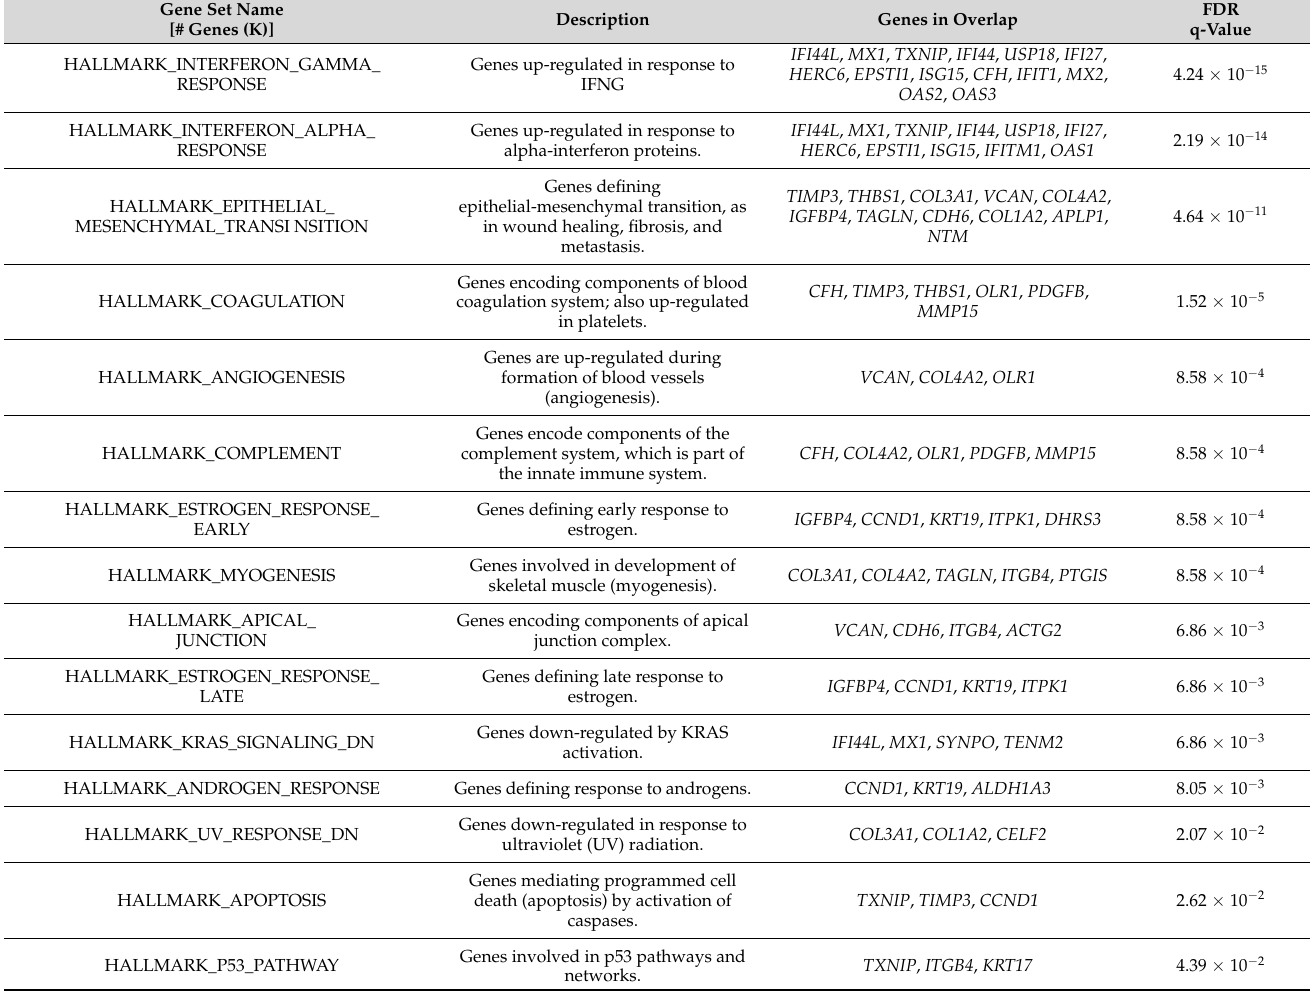
Table 4. GSEA based on the hallmark gene sets for downregulated genes of FE25L (p122) compared to FE25 (p19)